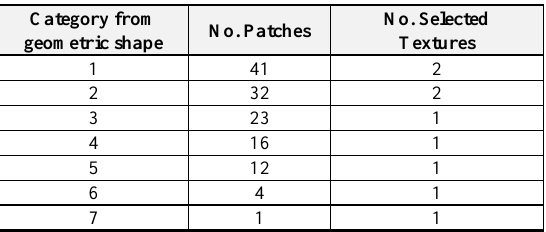
Table 2. The results of optimal texture selection